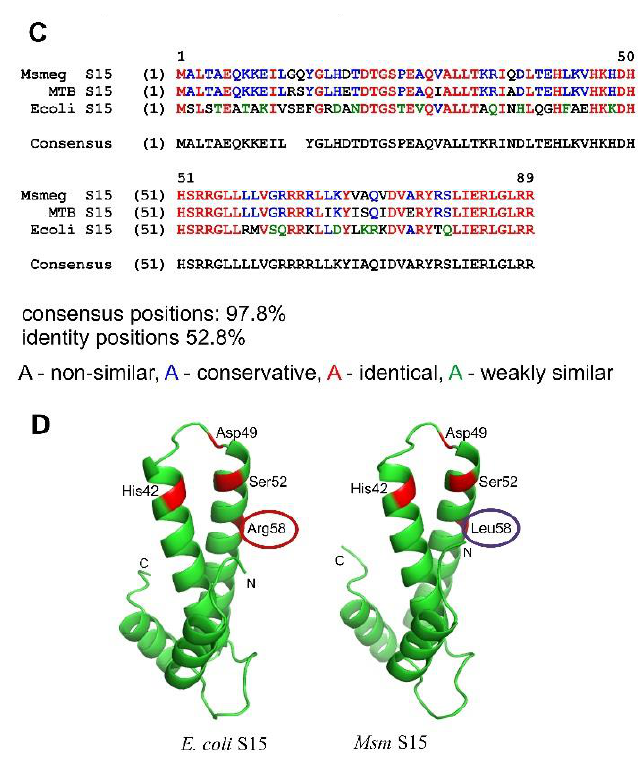
Figure 3. The Msm rpsO gene is feedback-regulated at the translation level, similar to E. coli rpsO . ( A ) Inhibition of the Msm rpsO-lacZ reporter expression in the presence of Msm S15 and E. coli S15 in trans . ( B ) Autogenous regulation of the E. coli rpsO-lacZ reporter: E. coli S15 in trans inhibits expression, while Msm S15 only has a marginal effect. ( C ) Alignments of S15 sequences from E. coli , Msm, and Mtb . ( D ) Three-dimensional structures of free S15 from E. coli and Msm as predicted by IntFOLD [45]; amino acid residues reported to be involved in mRNA binding by E. coli S15 [13] are shown.